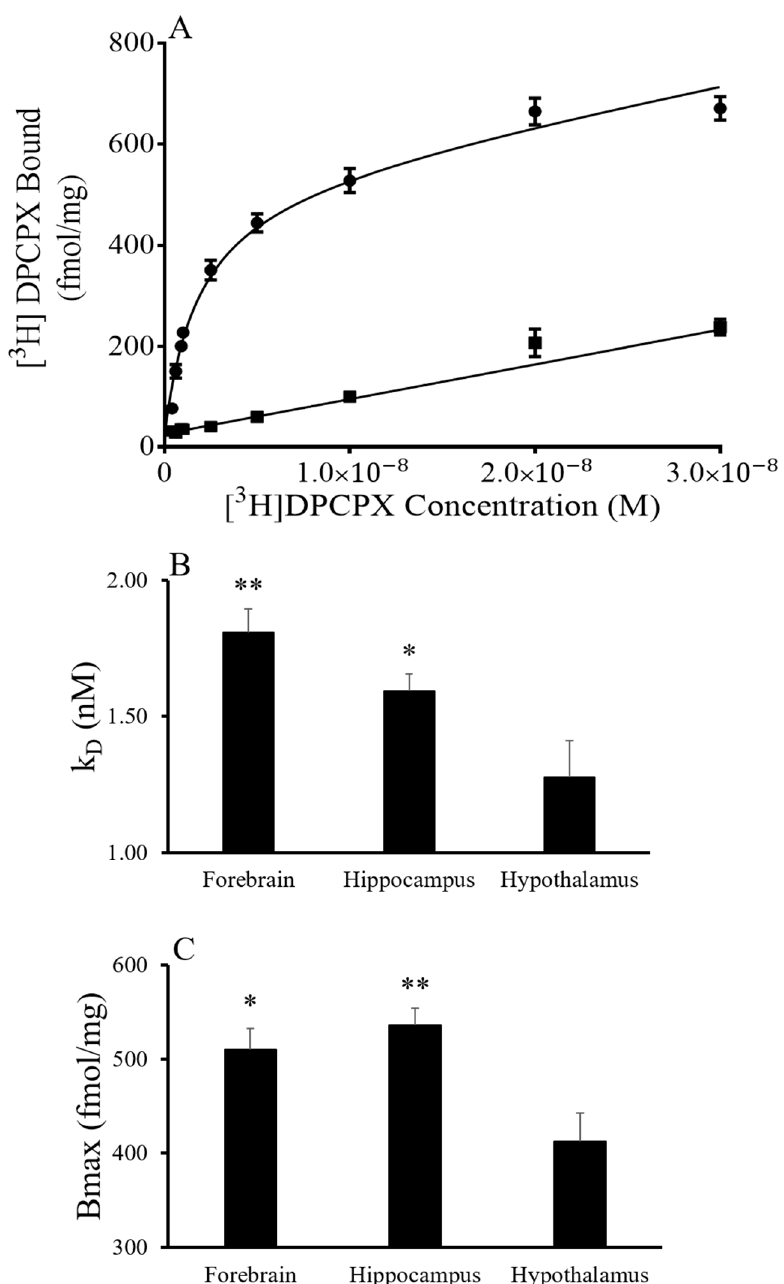
Figure 1. Kinetics of [ 3 H] DPCPX binding in AGS with results from summer and torpid groups combined. Binding of [ 3 H] DPCPX in the forebrain was similar in appearance to that seen in the hippocampus and hypothalamus ( A ). [ 3 H] DPCPX demonstrated nanomolar affinity for the A 1 AR in the three tissues tested. The affinity of [ 3 H] DPCPX binding was lower in the hypothalamus than in the other brain regions ( B ). Also, the number of A 1 AR, indicated by Bmax, in the hypothalamus during the torpid season was less than in the forebrain and hippocampus ( C ) ** p < 0.01, * p < 0.05 vs. hypothalamus, Tukey, n = 4–8.